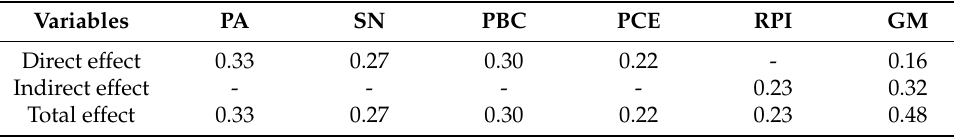
Figure 5. Key path of influencing factors. Table 7. The direct effect, indirect effect and total effect of predictors.